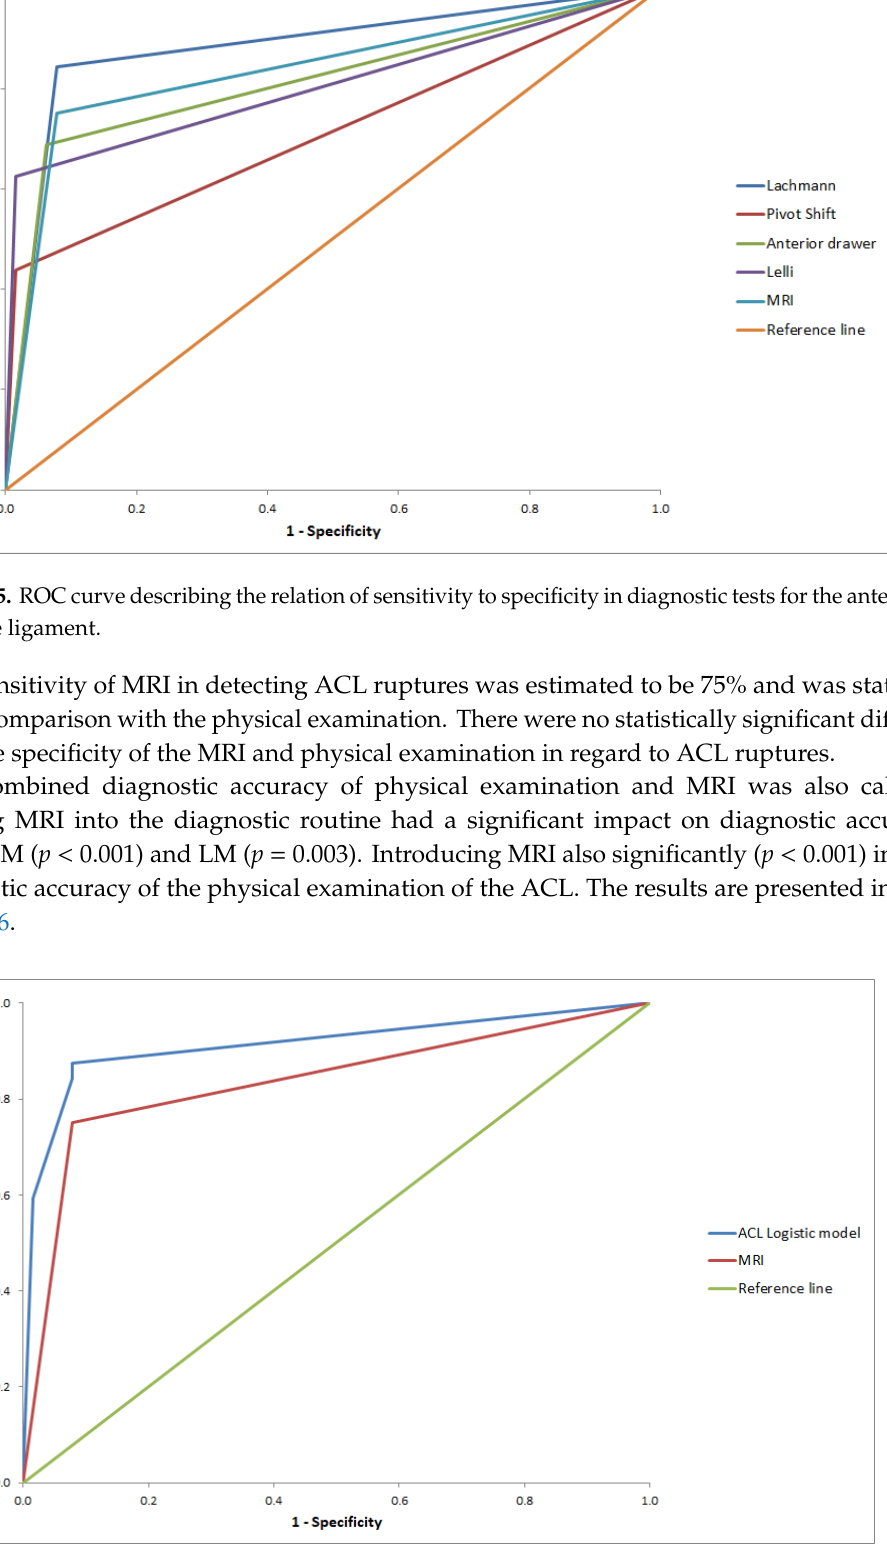
Figure 6. ROC curve describing the relation of sensitivity to specificity in clinical tests of the logistics model and MRI for anterior cruciate ligament.